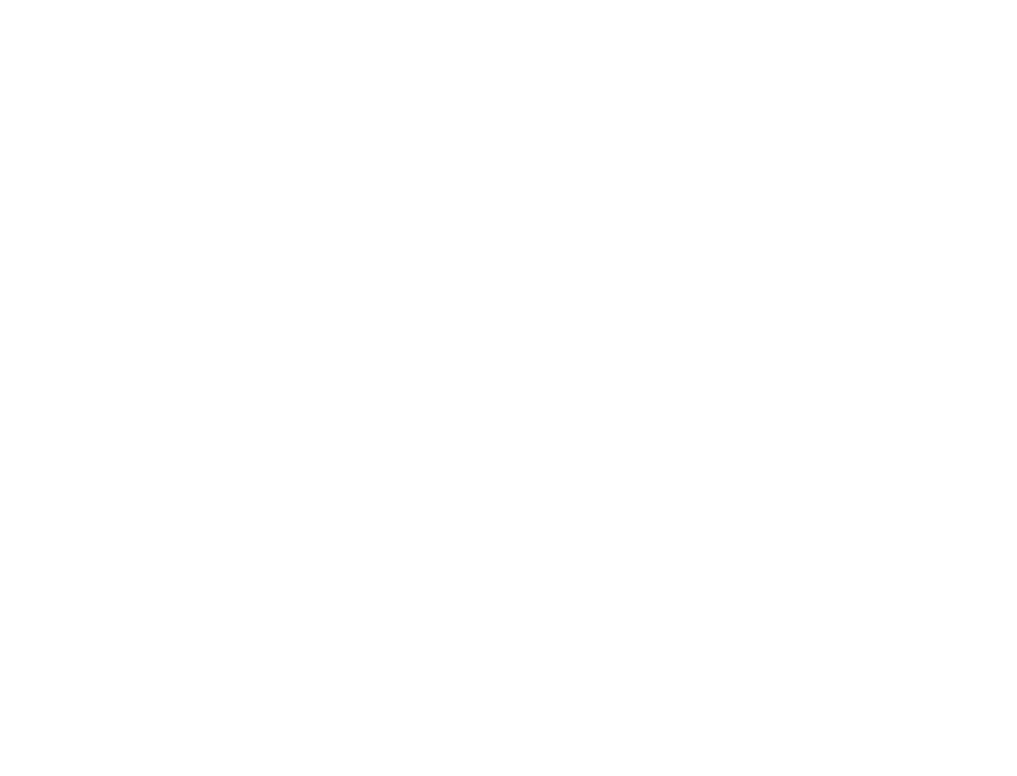
gyrus; IFGo, inferior frontal gyrus, pars opercularis; TPole, temporal pole; ANG, angular gyrus; DLPFC, dorsolateral prefrontal cortex; FI, frontoinsular cortex; R, right; L, left; Y, young group; M, middle-aged group; O, old